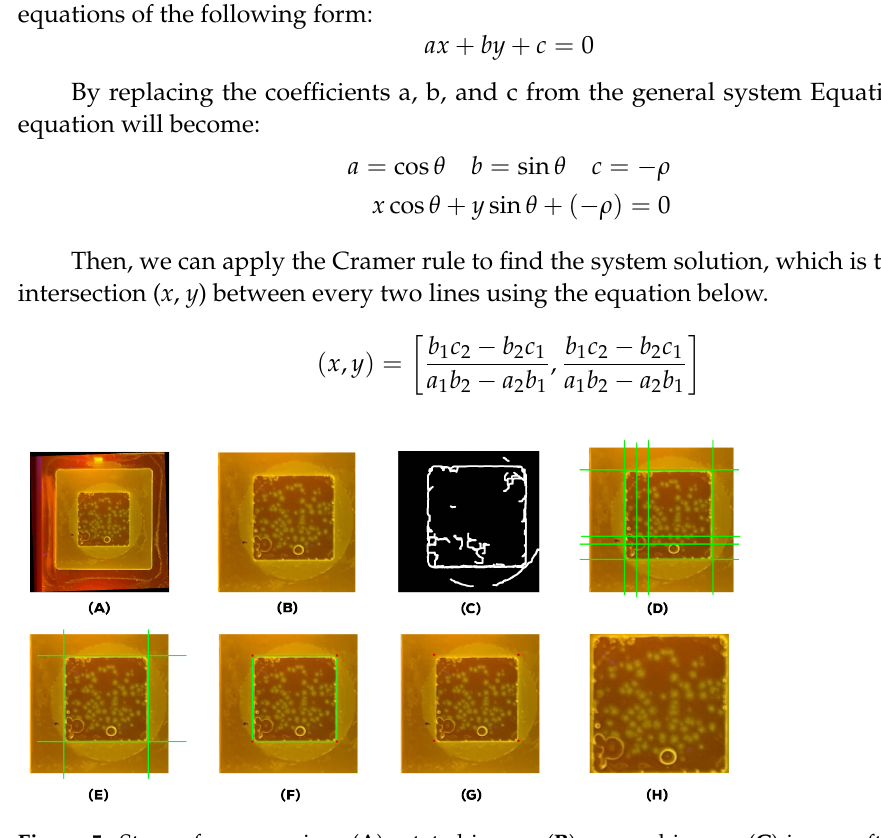
Figure 5. Steps of reprocessing: ( A ) rotated image, ( B ) zoomed image, ( C ) image after applying Canny edge detection, ( D , E ) intersection points identified using the Hough transform, ( F,G ) point selected for cropping the image, ( H ) cropped